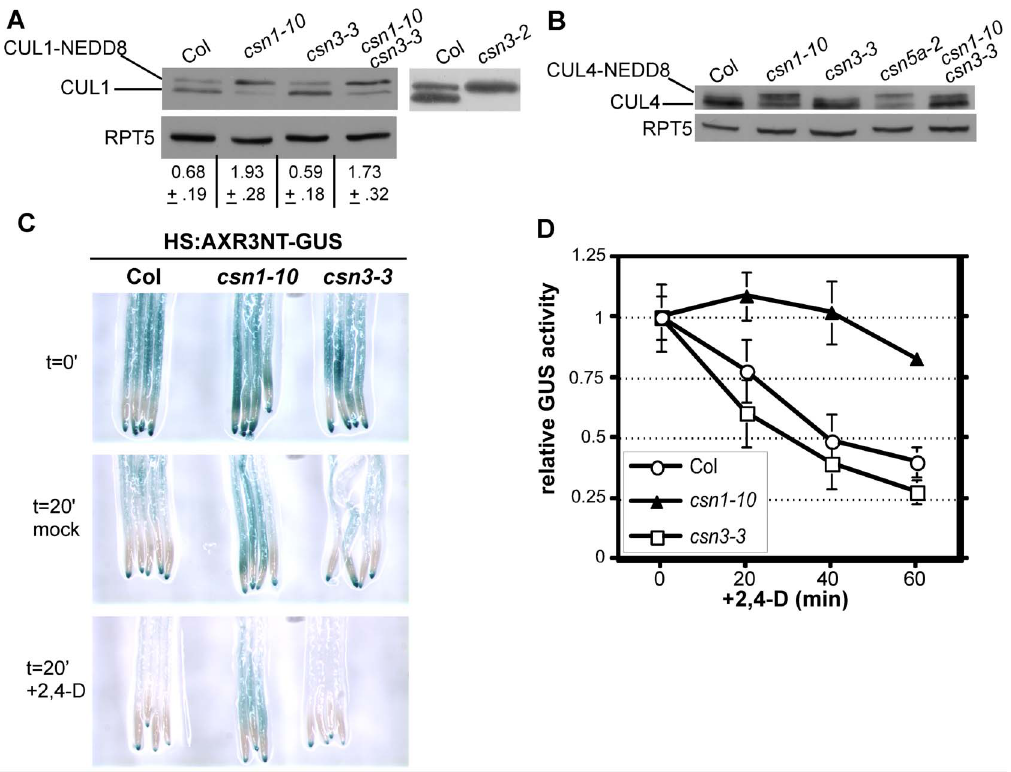
Figure 4. csn3-3 affects auxin response independent of SCF TIR1/AFB . ( A ) CUL1 western blot analysis of protein extracts prepared from Col and csn mutant seedlings. The upper band indicates the modified (neddylated) CUL1. RPT5 is shown as a loading control. Numbers below the blot indicate the ratio of CUL1-NEDD8:CUL1 6 SD from three experiments. ( B ) Western blot analysis of CUL4 neddylation status in Col and csn mutant seedling extracts. ( C ) Col, csn1-10 and csn3-3 carrying the HS:AXR3NT-GUS transgene were heat shocked for 2 h and stained immediately or following incubation with 1 m M 2,4-D for 20 min. ( D ) Quantitative measurement of the b -glucuronidase activity of the HS:AXR3NT-GUS reporter in Col, csn1-10 , and csn3-3 seedlings. Seedlings were heat-shocked for 2 h, and then returned to room temperature and treated with 1 m M 2,4-D for 20, 40, or 60 min. b -glucuronidase activity is presented as the fraction remaining compared to the 0 min time point. Values shown depict the mean 6 SD of 6 technical replicates. Similar results were obtained in two additional biological